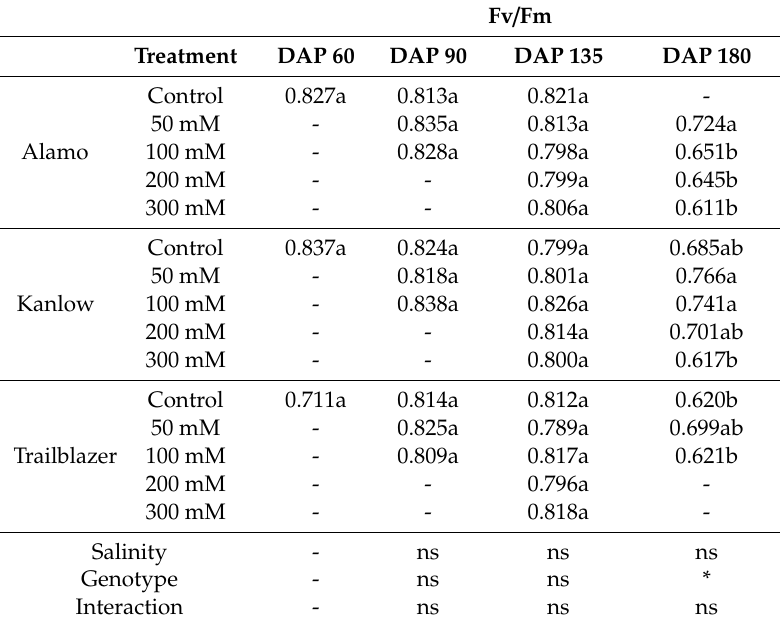
Table 3. The maximum quantum e ffi ciency of PSII (Fv / Fm) for the control, 50, 100, 200 and 300 mM NaCl treatments for Alamo, Kanlow and Trailblazer genotypes of Panicum virgatum